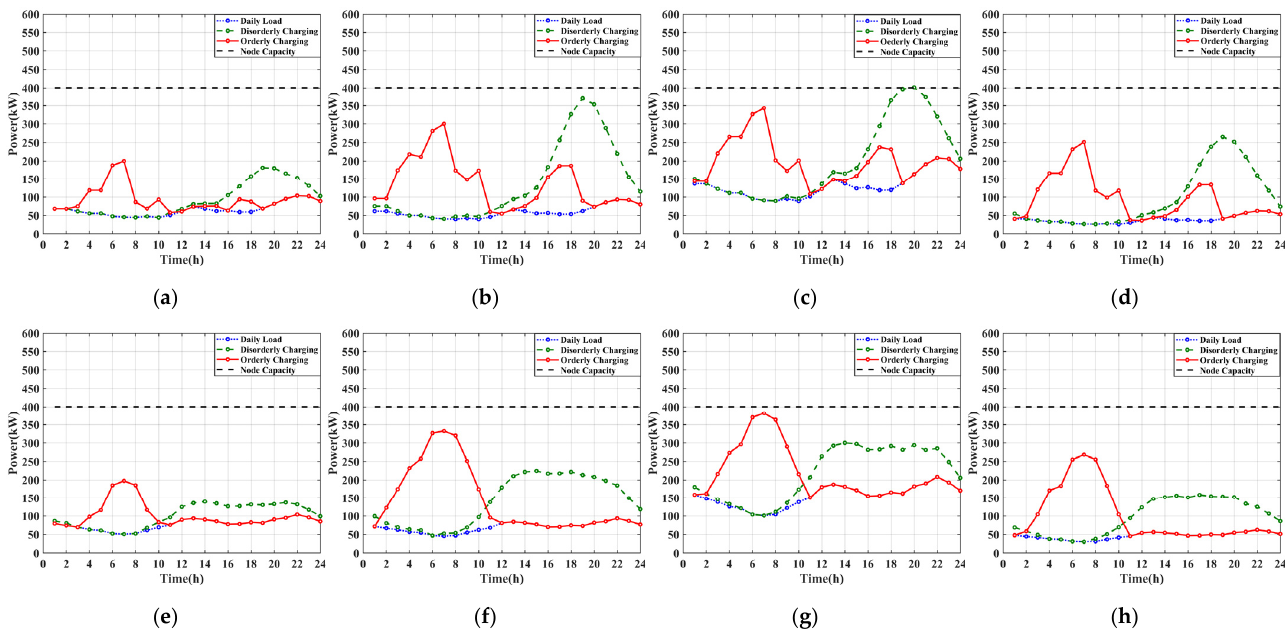
Figure 6. EV access node load power: ( a ) Node 2 (weekday), ( b ) Node 3 (weekday), ( c ) Node 7 (weekday), ( d ) Node 26 (weekday), ( e ) Node 2 (weekend), ( f ) Node 3 (weekend), ( g ) Node 7 (weekend), ( h ) Node 26 (weekend).